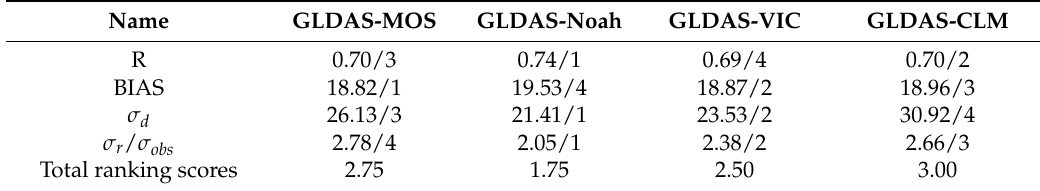
Table 2. The average ranking scores of runoff data from the four GLDAS models. Number a/number b: a represents the values of 4 statistical parameters; b represents the total ranking scores.